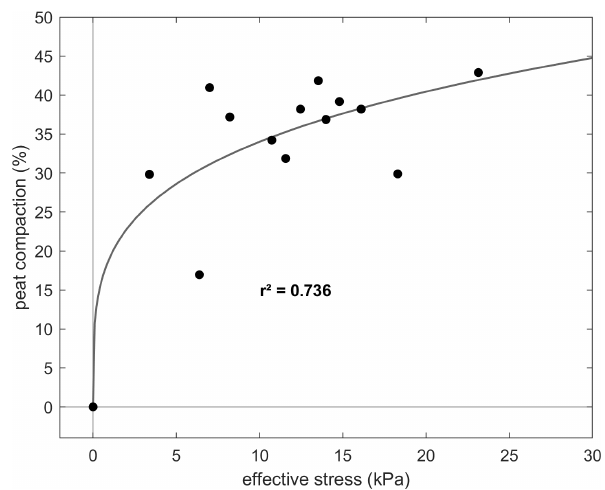
Figure A9. Peat compaction (%) as a function of the effective stress exerted on the peat layer (kPa). The fitted fourth root function is based on a dataset for central Canadian floodplains ( n = 14) (Van Asselen et al.,